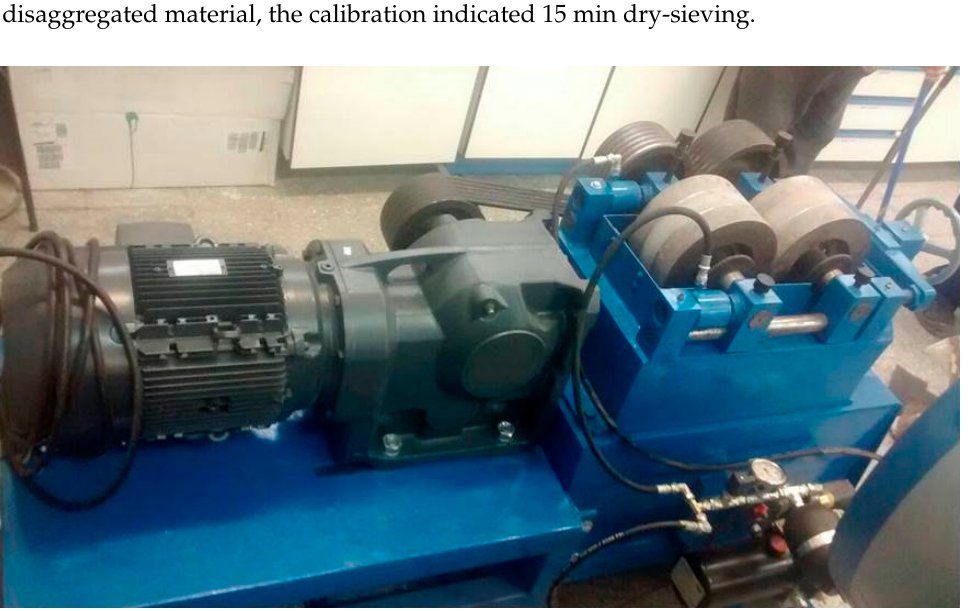
Figure 1. Roll crusher transformed into a high-pressure grinding roller with a 15 kW engine and full hydraulic piston system.